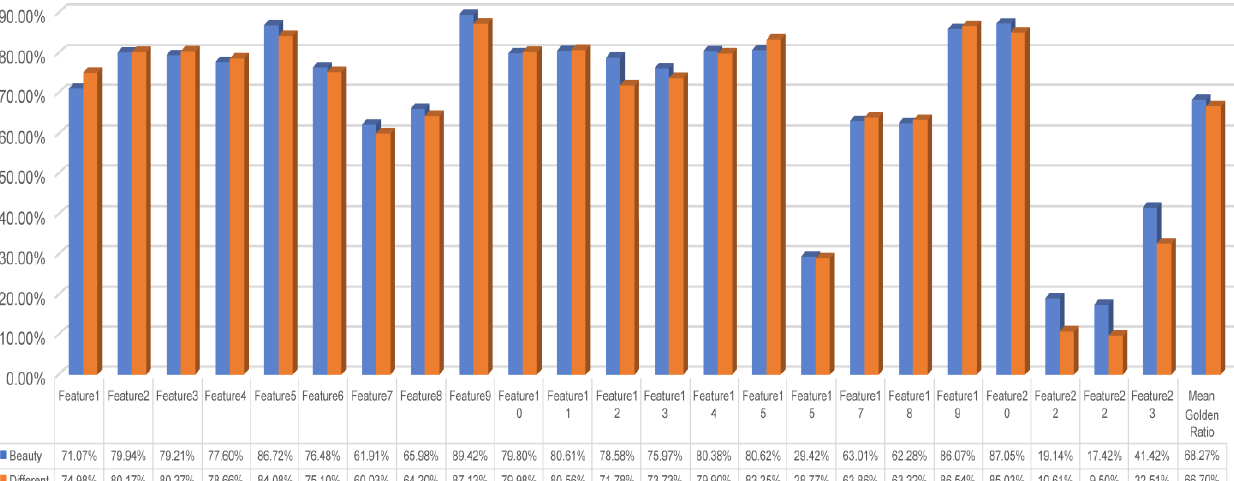
Table 8. Top-five facial attributes correlation with beauty decision.